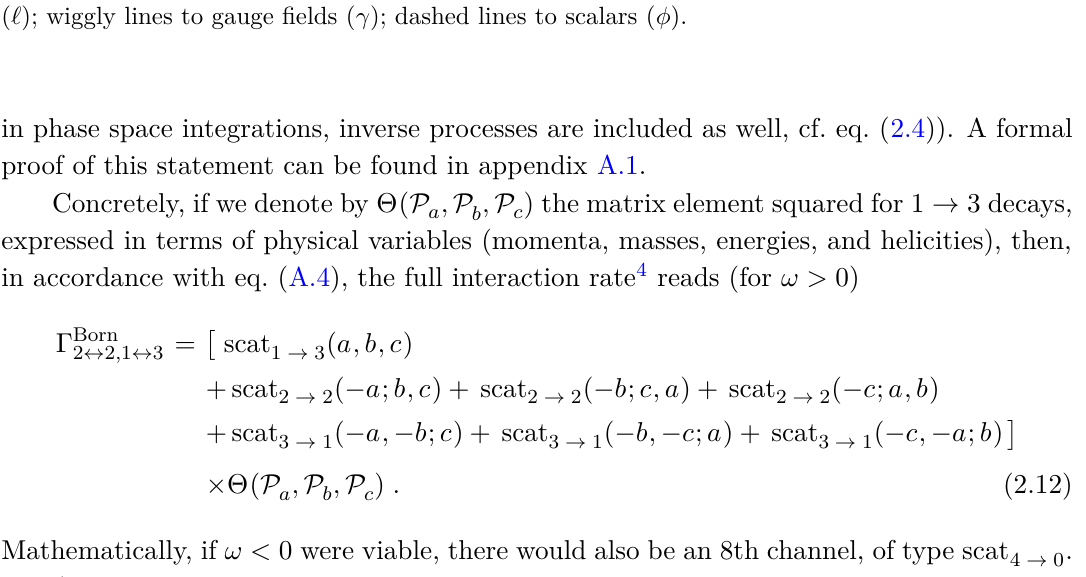
= scat ( ‘, φ ) 4 E · P , and the 1 → 3 processes 1 → 2 1 → 2 ‘